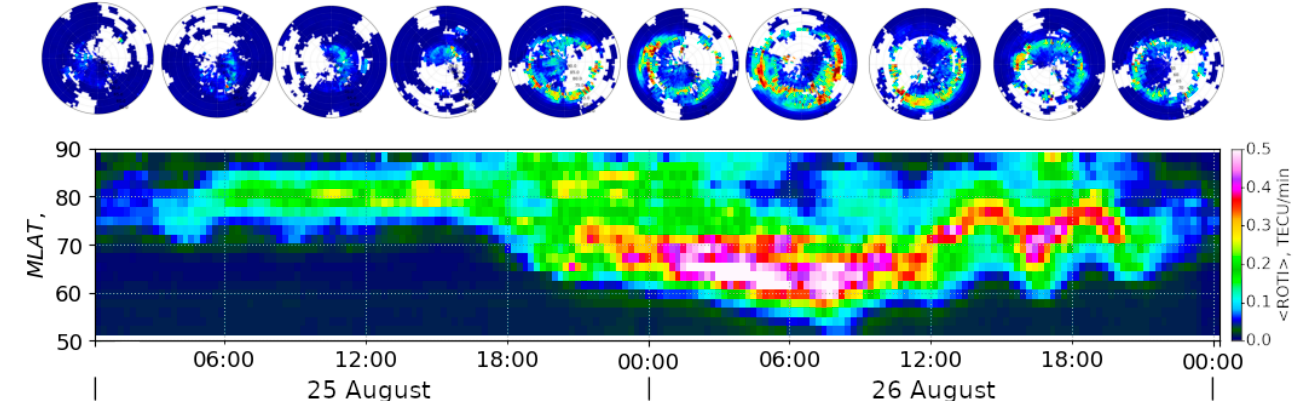
Figure 3. ROTI keogram during a magnetic storm of 25–26 August 2018 ( bottom ), with several corresponding maps ( top ).